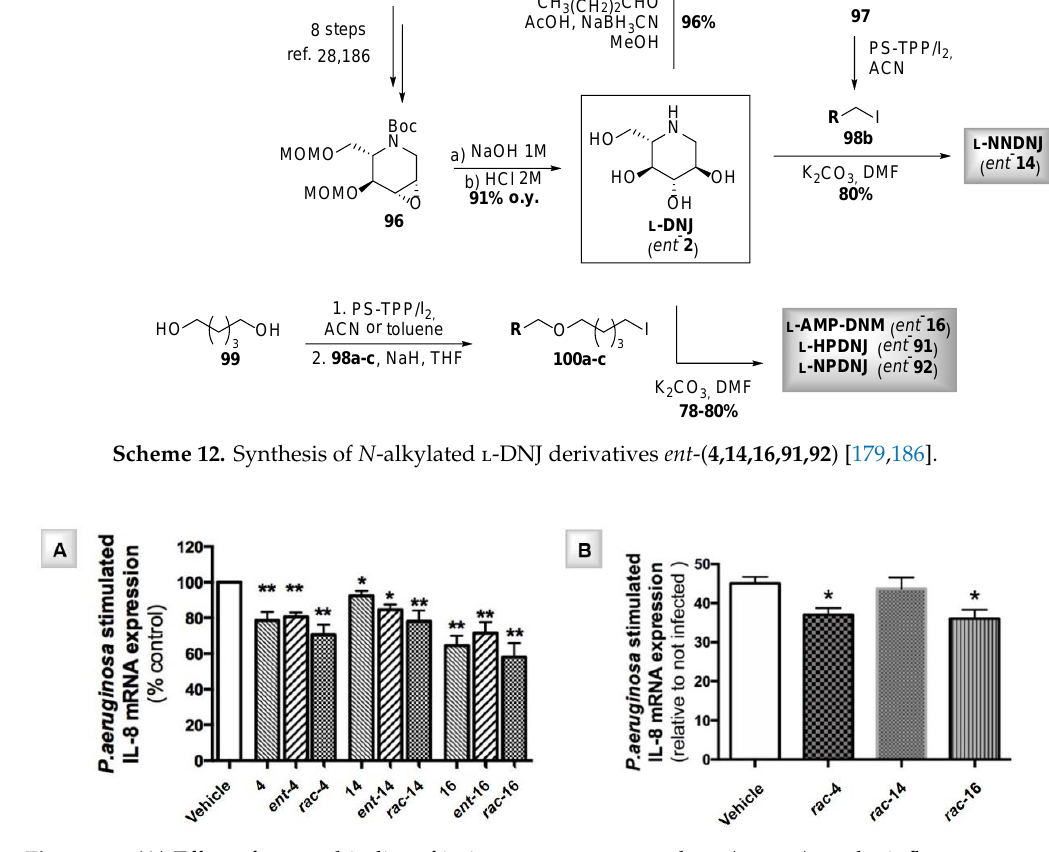
Figure 24. ( A ) Effect of 4 and ent - 4 on cells recruited in bronchoalveolar lavage (BAL) of C57Bl/6NCr mice infected by P. aeruginosa (i, total cells; ii. neutrophils; iii. alveolar macrophages). ( B ) NLGase activity in the lungs of mice infected by P. aeruginosa. * p < 0.05; ** p < 0.01. This figure was reprinted from [179], with permission from Elsevier. 5. Concluding Remarks Iminosugars represent the most important class of glycomimetics, showing high pharmacological potential in several therapeutic fields, as a result of their excellent ability to interact with carbohydrate-processing enzymes. Over the last years, these properties have been applied to